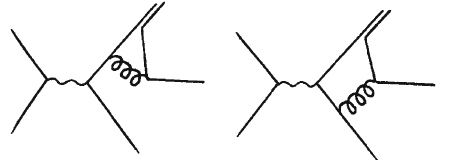
Fig. 1 Feynman diagrams used to calculate the c → ψ fragmentation function from e + e − annihilation, e + e − → γ ∗ → ψ + c + ¯ c